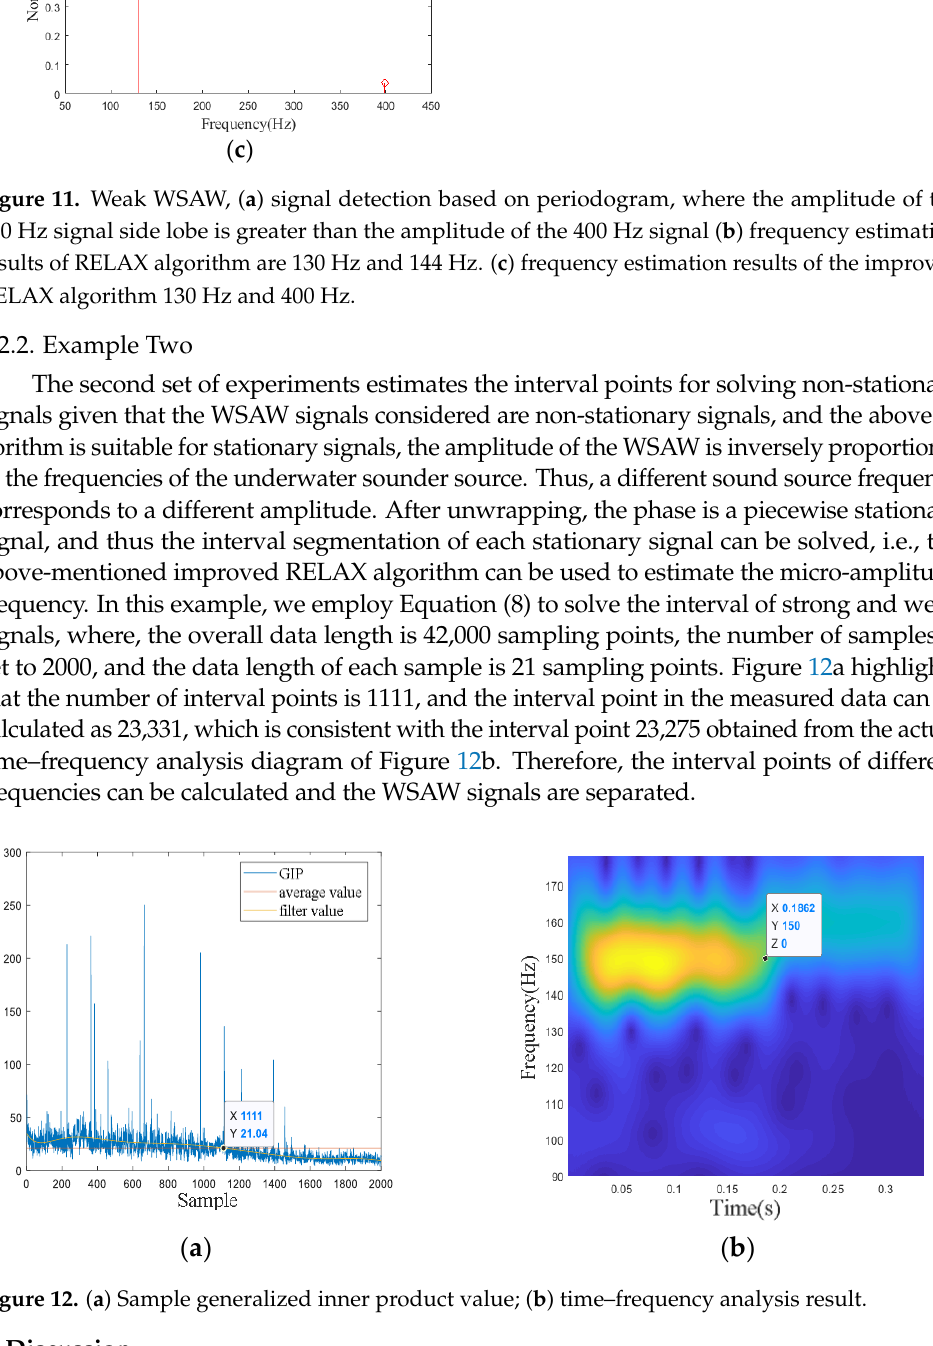
Figure 11. Weak WSAW, ( a ) signal detection based on periodogram, where the amplitude of the 130